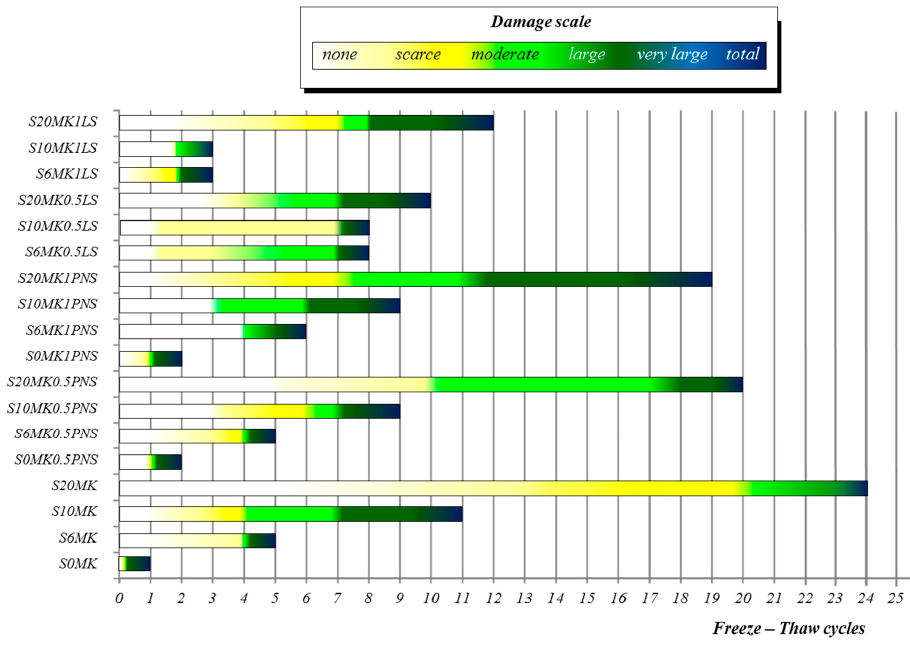
Figure 11. Alteration degrees of grouts after freeze-thaw cycles.